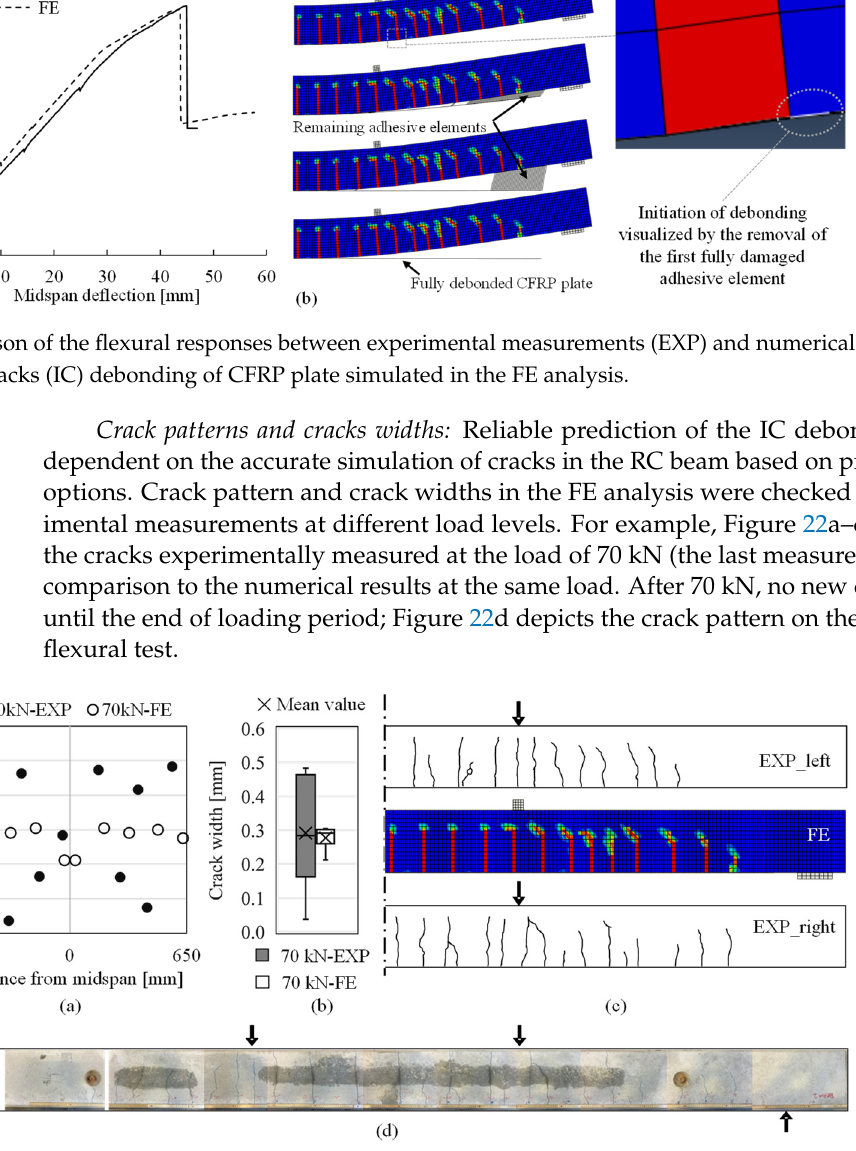
Figure 22. Comparison of cracks formed in the CFRP-strengthened RC beam at the load of 70 kN regarding ( a ) crack pattern; ( b ) crack widths in the constant moment region (EXP: experimental results, FE: numerical results); ( c ) crack widths compared in box-and-whisker plots and ( d ) assembled photos depicting the crack pattern after the flexural test.